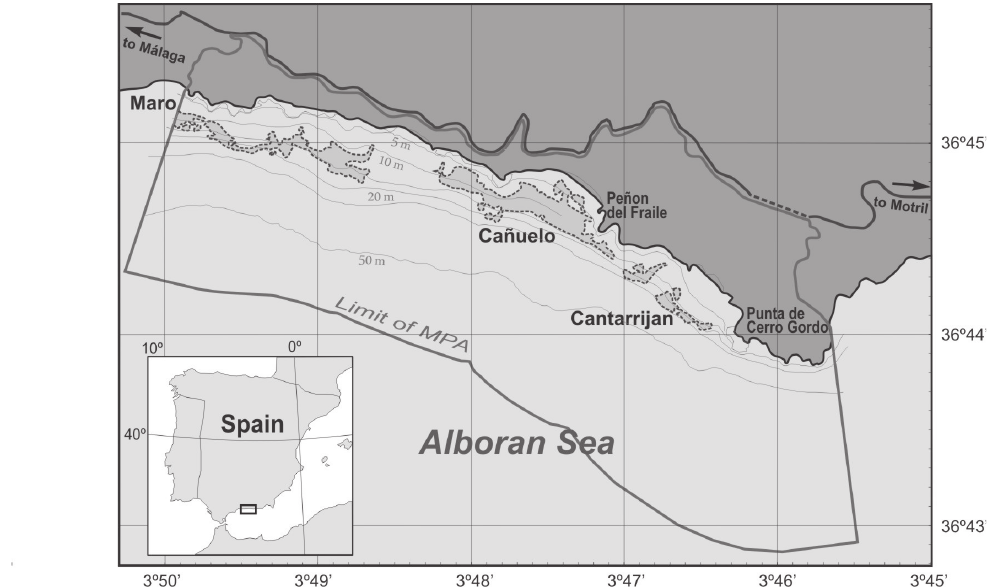
Fig . 1. – Location map of the study area, displaying the presence and distribution of Zostera marina beds within the mPa “Paraje natural de acantilados de maro - Cerro gordo” based on Bañares-españa et al.